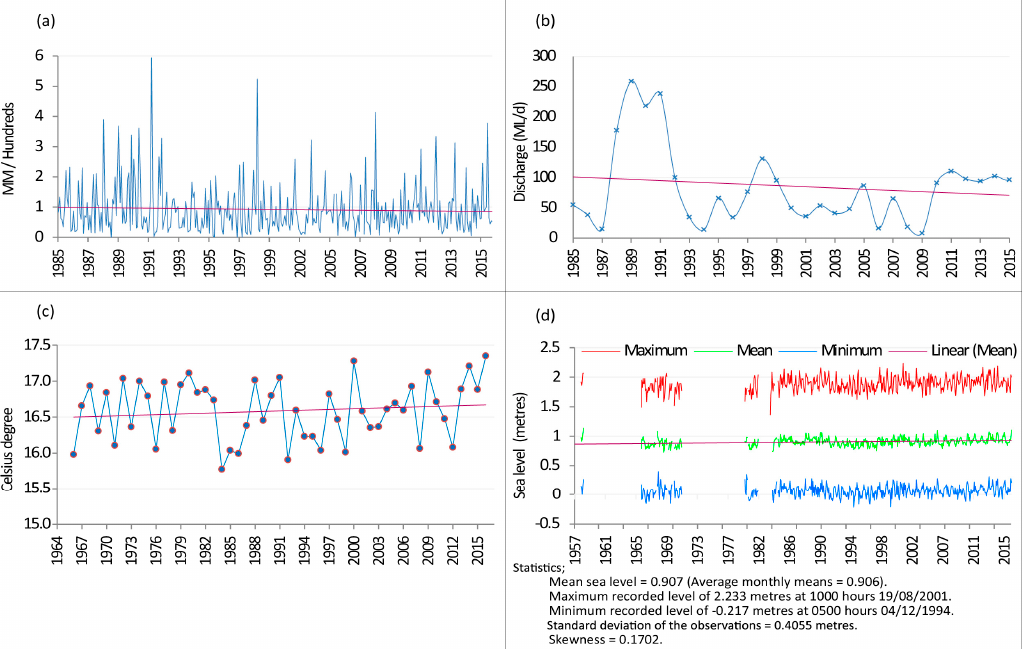
Figure 4. Climate trends for Wandandian Creek estuary; ( a ) the total monthly precipitation, ( b ) annual flow discharge in Wandandian Creek, ( c ) mean annual air temperature, and ( d ) monthly mean sea level at Port Kembla (1957 to 2016; red is the maximum, green is the mean, and blue is the minimum). Sources [24,30] .